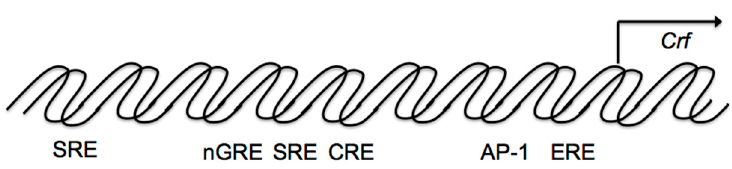
Figure 3. Schematic model of transcriptional regulation of the corticotropin-releasing factor ( Crf ) promoter. Possible binding sites for transcriptional factors such as the cAMP-response element (CRE), activator protein 1 (AP-1) protein (Fos/Jun) binding sites, the half glucocorticoid regulatory element (GRE), and the half estrogen-responsive element (ERE) in the proximal Crf promoter. The Crf promoter region also contributes to glucocorticoid inhibition as a negative GRE (nGRE), as it includes a serum response element (SRE).